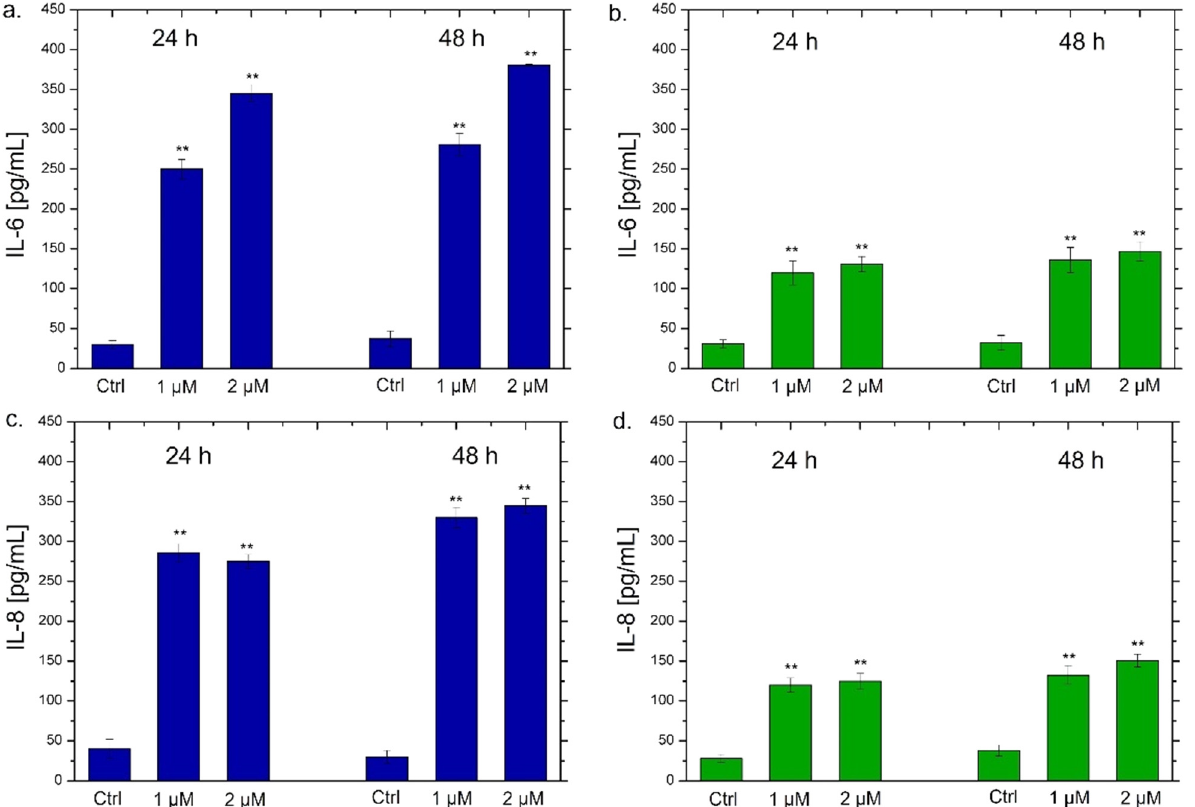
Figure 8. IL-6 ( a , b ) and IL-8 ( c , d ) levels expressed as pg/mL measured after exposure of THP-1 cells to conventional Ag NPs and green Ag NPs (1 µ M and 2 µ M) for 24 h and 48 h. The cytokine amount was detected in supernatants derived from the control and the treated cells by ELISA assay. The data were reported as the mean ± standard deviation of three separate experiments. p -value < 0.01 (<0.01 **) compared to the control of each time point.